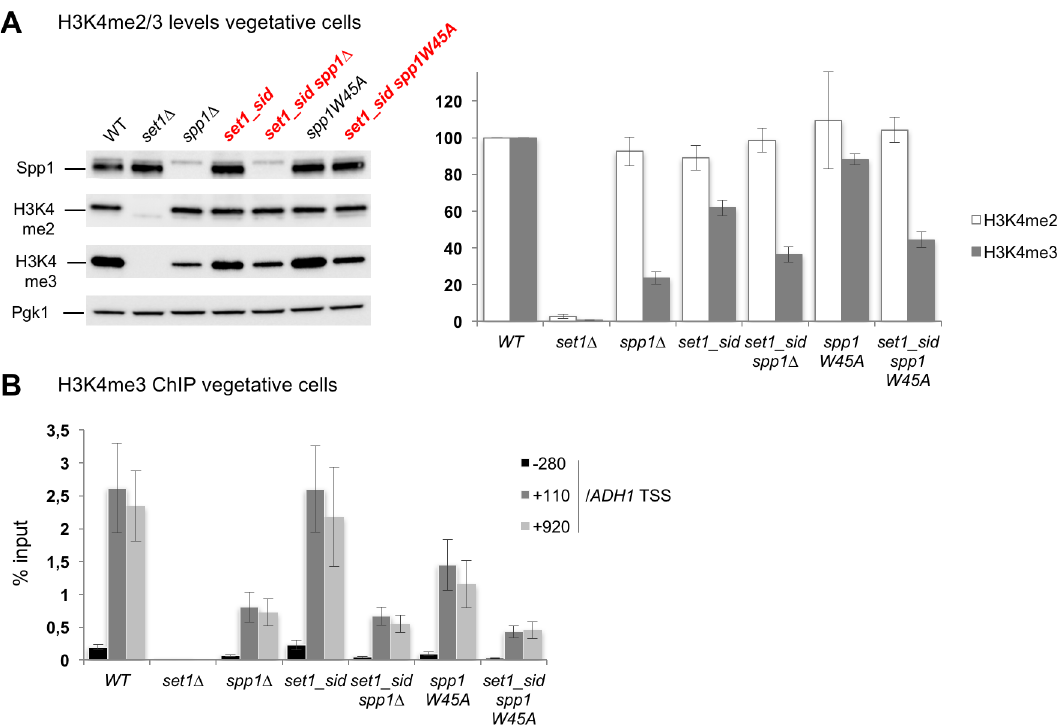
Fig 5. In the set1_sid mutant, Spp1 is still important to maintain H3K4me3 levels. (A) Histone H3K4 methylation levels in vegetatively growing cells detected by Western blot. Anti-Spp1, anti H3K4me2, anti-H3K4me3 or anti-Pgk1 antibodies were used, as indicated. A representative experiment is shown. WT: ORT4601; set1 Δ :ORT4784; spp1 Δ : VBH152; set1_sid :VBH1881; set1_sid spp1 Δ : VBH1972; spp1W45A :VBH1419; set1_sid spp1W45A :VBH2021. The bar graph on the right indicates histone modification levels normalized to Pgk1 levels and relative to the WT strain. Values are the mean ± S.E.M. of the normalized relative levels from 3 to 6 replicates for each strain, except for spp1W45A ,where only 2 replicates are available and the error bars indicate the range. See also S4 Table. (B) Histone H3K4me3 levels in vegetatively growing cells detected by ChIP at the highly transcribed ADH1 gene. Same strains as in A. Values are expressed as % of input DNA, and are the mean ± S.E.M. of six independent experiments.